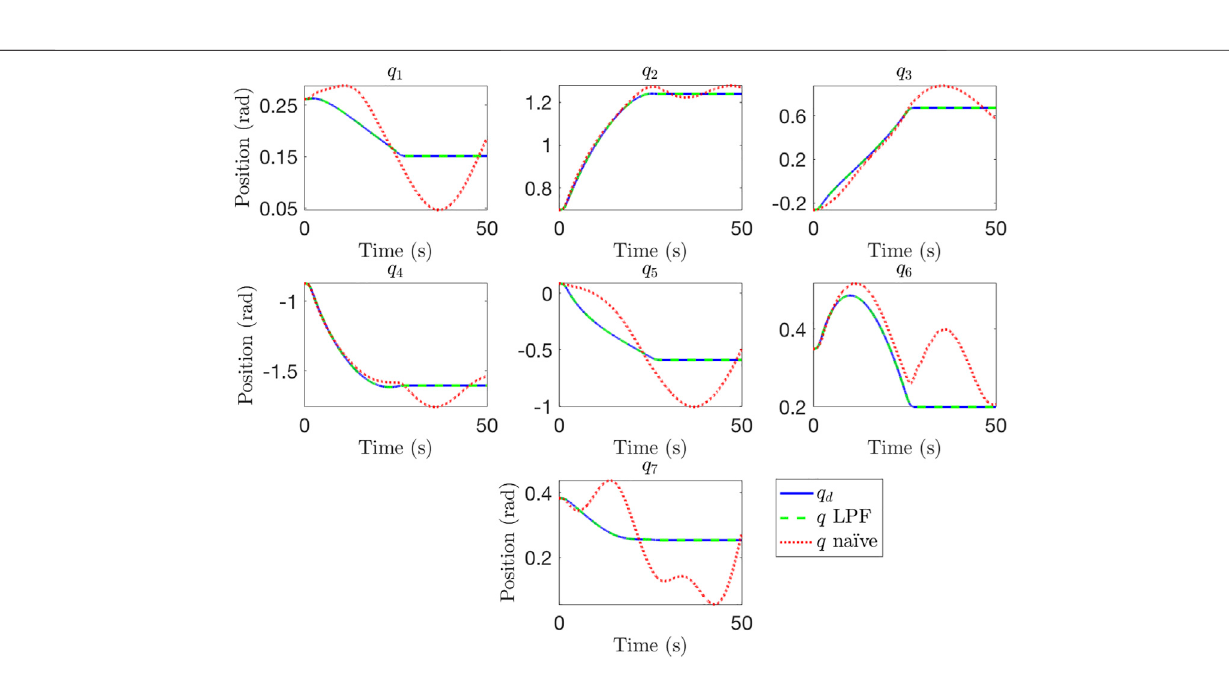
Frontiers in Robotics and AI |